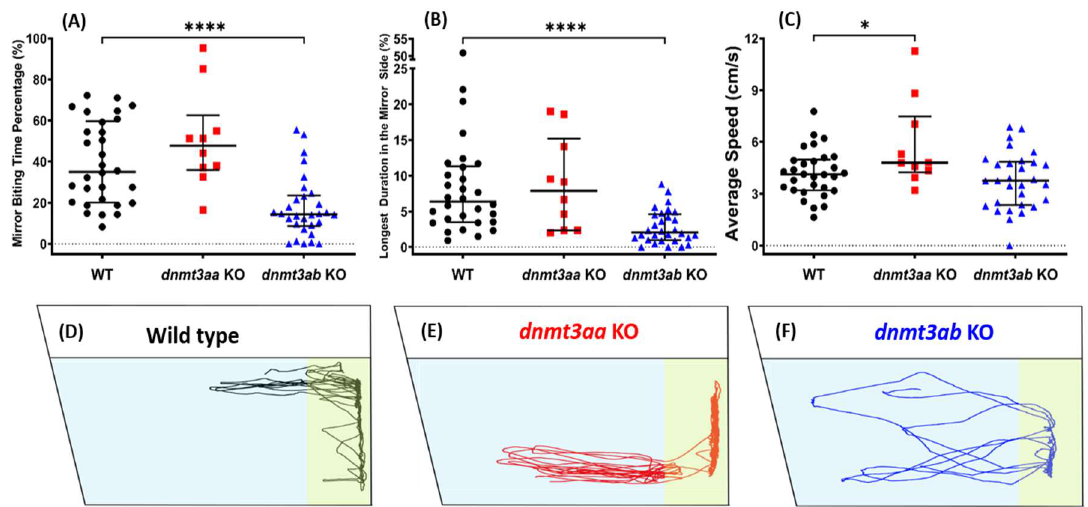
Figure 4. Comparison of mirror biting behavior endpoints among wild-type, dnmt3aa , and dnmt3ab mutant fish. ( A ) Mirror biting time percentage, ( B ) longest duration in the mirror side, and ( C ) average speed were analyzed. The data are expressed as the median with interquartile range and analyzed by Mann–Whitney test ( n = 30 for wild type ; n = 10 for dnmt3aa KO fish; n = 30 for dnmt3ab KO fish; * p < 0.05, **** p < 0.0001). ( D – F ) The locomotion trajectories of a single fish of wild type, dnmt3aa KO, and dnmt3ab KO fish, respectively, during the mirror biting test. The mirrors were put on the right side of the fish tank and the mirror biting zones were highlighted with yellow color.